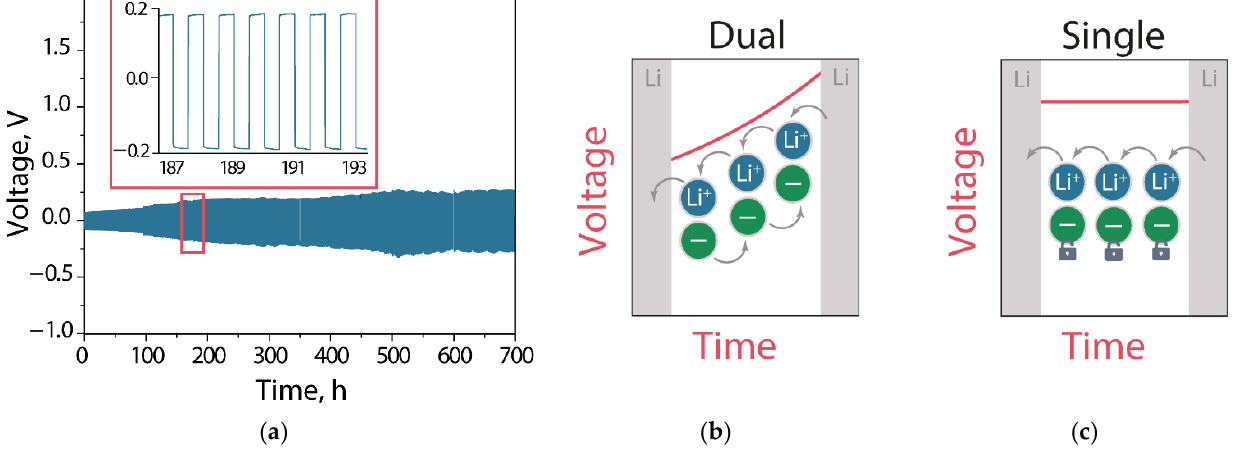
Figure 7. ( a ) Galvanostatic cycling curves of a symmetrical Li|Li cell with SSEBS-Ph-EC-DMA-based electrolytes at 0.1 mA∙cm −2 with a cut-off capacity of 0.05 mAh∙cm −2 . Schematic illustration of the electrolytes at 0.1 mA · cm − 2 with a cut-off capacity of 0.05 mAh · cm − 2 . Schematic illustration of the behavior of ( b ) dual- and ( c ) single-ion conductors. behavior of ( b ) dual- and ( c ) single-ion